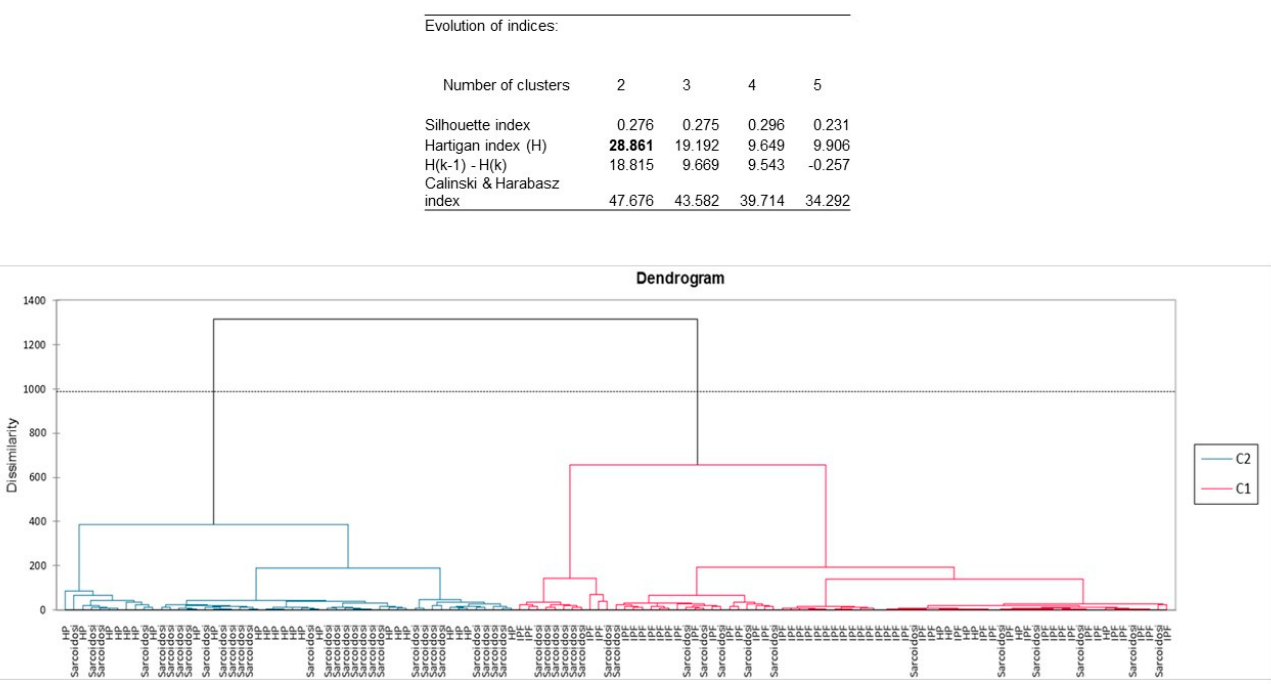
Figure 1. Dendogram plot from agglomerative hierarchical clustering (AHC) analysis clustered the three groups of diagnoses (IPF, HP, sarcoidosis) based on dissimilarities between the median APC (allophycocyanin) values of 37 EV surface markers. Hartigan index defined 2 as the appropriate number of clusters because of the greater difference (the value displayed in bold). The first cluster (displayed in blue, mainly formed by granulomatous disease: HP and sarcoidosis) is more homogeneous than the second one (it is flatter on the dendrogram, mainly formed by IPF patients). PCA plots (Figure 2) were performed to distinguish the three groups (IPF, HP and sarcoidosis). The analysis showed that the three groups were separated on the basis of 37 surface exosome markers. The first and second components explained 44.53% and 15.55% of the total variance.